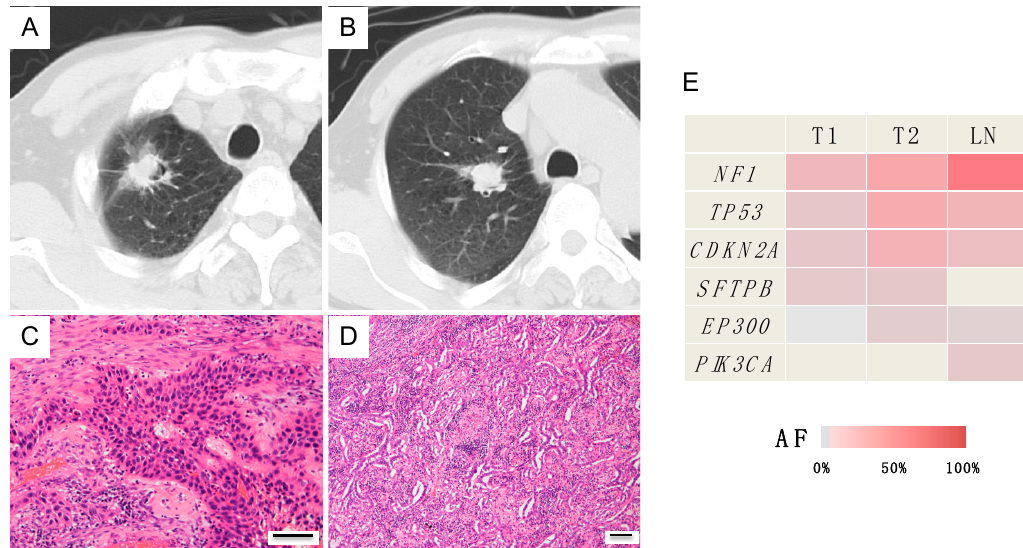
Figure 2. Heatmap of gene mutations in patients with metastatic lung cancers. The mutation profiles were consistent between the individual tumors in each case and the tumors were identified as intrapulmonary metastasis. Case 33 was synchronous cancers, while the other cases in this figure were metachronous cancers. The remaining 2 cases of metastatic lung cancers (cases 10 and 30 in Tables 1 and S2) that are not shown in this figure are described in detail in the Case presentation section. r, right; S, segment; AF, allele fraction